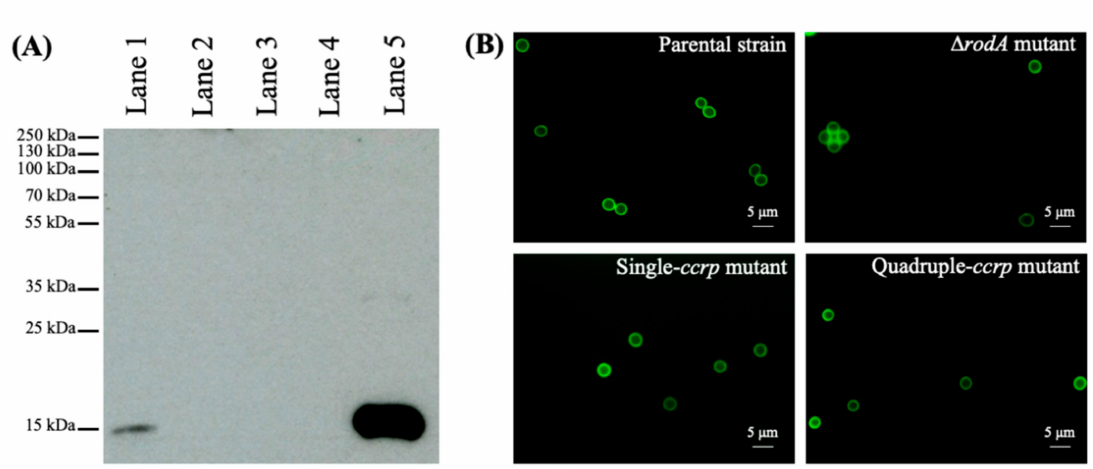
Figure 2. ( A ) Western blot analysis of the cytoplasm contents of conidia for RodAp probed with polyclonal anti-RodAp antibodies; recombinant RodAp was used as the control (lane 5); lanes 1–4 represent the cytoplasmic contents from the parental strain, ∆ rodA , single and quadruple ccrp-mutants, respectively. Only the conidial cytoplasm of the parental strain (Lane 1) showed a positive band for RodAp. ( B ) Conidial labeling with fluorescein isothiocyanate; both ∆ rodA and ccrp-mutant conidia showed only surface labeling similar to parental strain conidia, suggesting that the cell wall permeability of the rodletless mutants (by gene deletion or RodAp-point mutations) were unaltered compared to parental strain